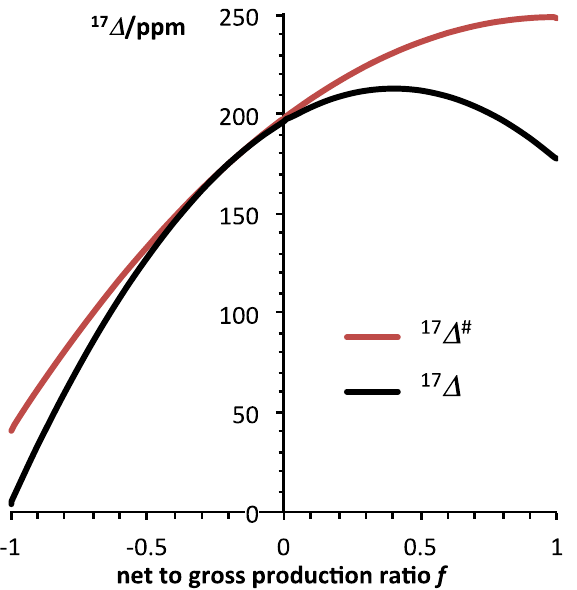
Fig. 1. Effect of the net to gross production ratio f on the steady-state 17 O excess defined by Eq. (7), i.e. 17 1 # , and Eq. (4) i.e. 17 1 , with λ = κ = γ R = 17 ε R / 18 ε R = 0.5179, 18 ε R =− 20‰, 18 δ P =− 23.323‰ and 17 δ P =− 11.902‰. The steady-state δ values used to calculate the steady-state 17 O excess have been calculated according to Eq. (31).